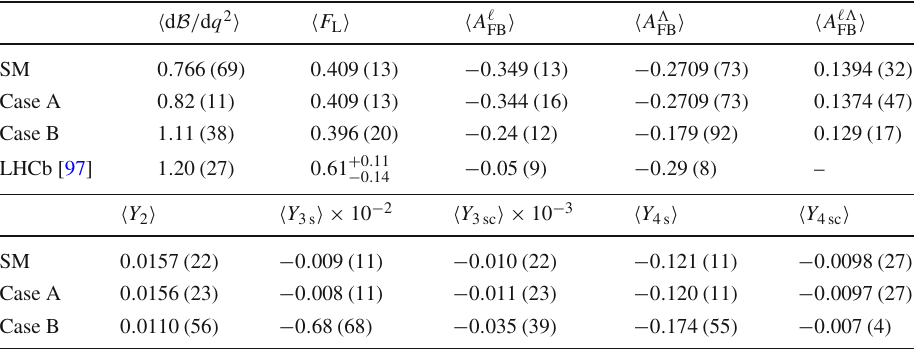
Table 4 Comparison of our results for the (cid:2) → (cid:2)( → p π − )μ + μ − b observables with the LHCb data (where available) in the bin [ 15 , 20 ] GeV 2 . The uncertainties of A2HDM results mainly come from the (cid:2) b → (cid:2) transition form factors and the model parameters. The differential branching fraction is given in units of 10 − 7 GeV −